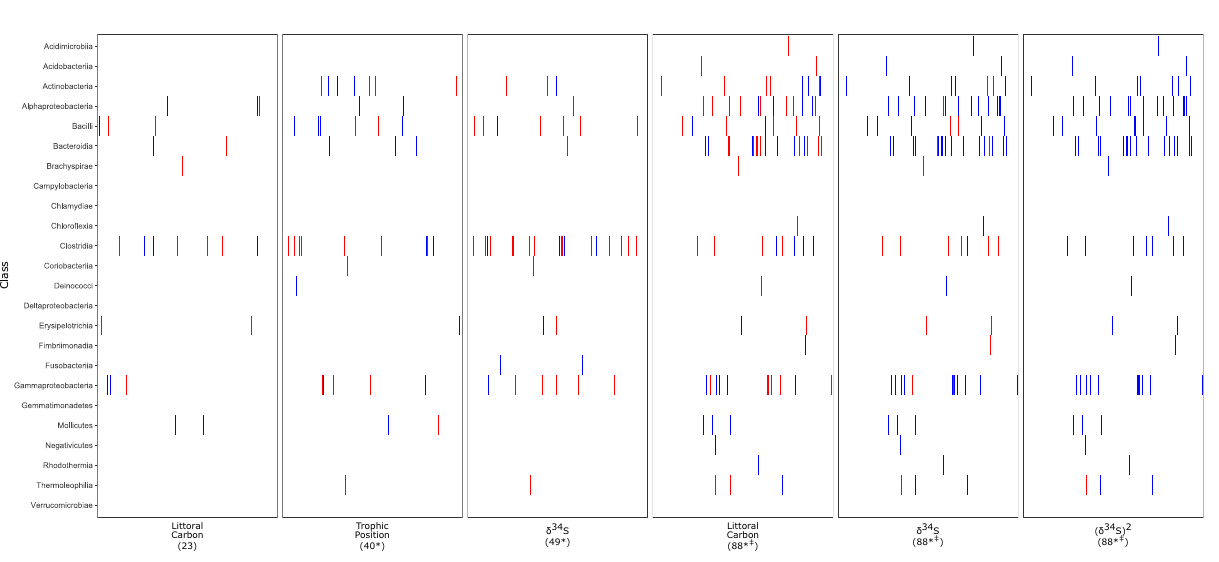
Figure 3. Quasibinomial effects of various diet metrics on the abundance of the 424 most abundant ASVs of the murre fecal microbiome. Columns contain the models of a diet metric for ASVs from a bacterial class in each row. Vertical bars represent an ASV within the given class that accounts for > 0.01% mean relative abundance and that has a positive or negative association with a particular metric. For ASVs with a red bar, its relative abundance increases with the metric. For ASVs with a blue bar, relative abundance decreased with the metric. Numbers under the different diet metrics indicate the number of ASVs for which an effect of the metric was observed. Numbers with an asterisk (*) indicate that the proportion of ASVs with an effect of the metric surpasses the expected 5% false positive rate. Metrics with a double dagger (‡) form part of the same model which combined the linear effect of the proportion of littoral carbon and the quadratic effect of